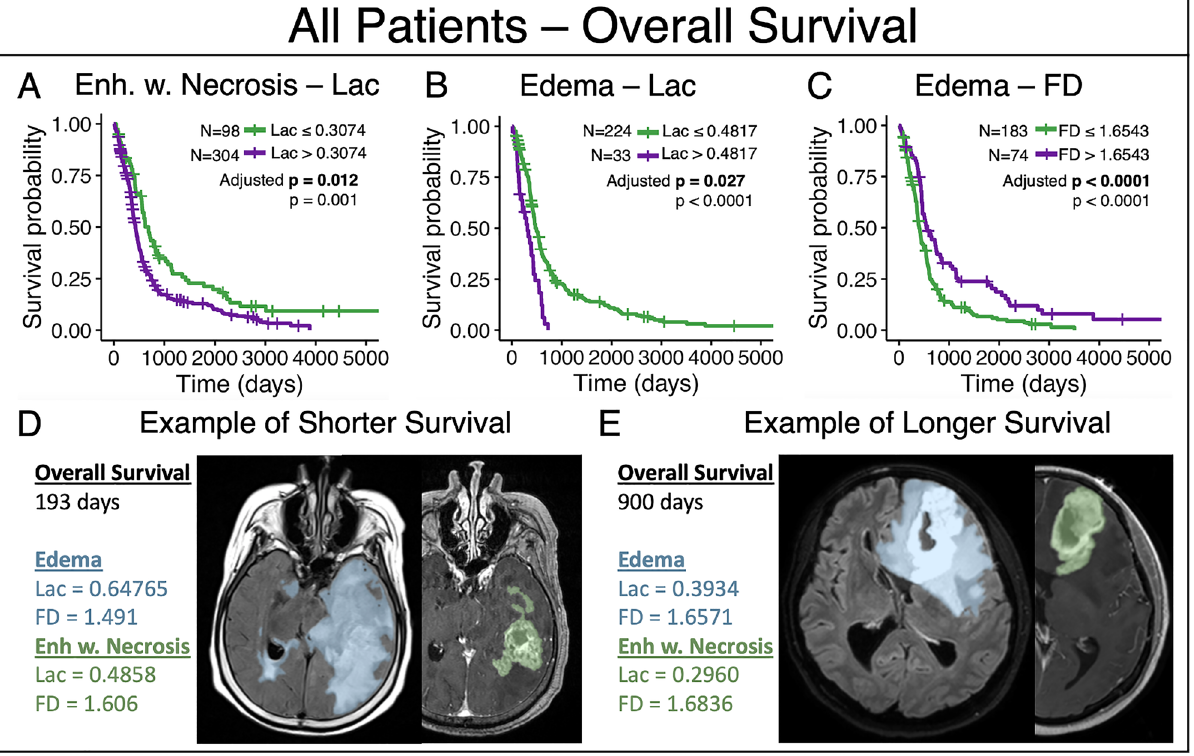
Figure 2. Results amongst all patients that remained significant with adjustment ( A ) The group of lower median lacunarity values of enhancement with necrosis (Lac ≤ 0.3074) were associated with prolonged overall survival. ( B ) The group of lower median lacunarity values of edema were associated with longer overall survival (Lac ≤ 0.4817). ( C ) The group of higher median fractal dimension values of edema were associated with longer overall survival (FD > 1.6543). ( D ) An example patient with lower overall survival of 193 days who consistently fell into the short overall survival groups of subpanels A-C. Example MRI slices shown with translucent segmentation overlays. ( E ) An example patient with longer overall survival of 900 days, who consistently fell into the longer overall survival groups of subpanels A-C. Example MRI slices shown with translucent segmentation